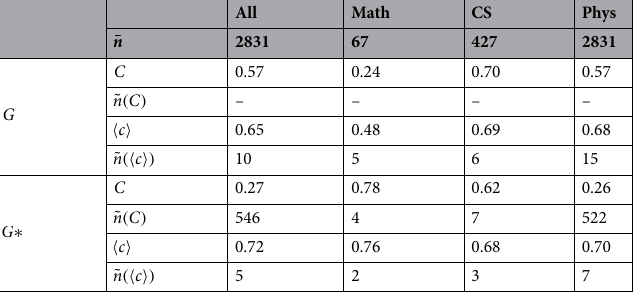
Table 3. Maturation indices and maturation values of the graphs’ clustering properties. All notations and definitions are reported in the text. The symbol “–” reflects the fact that the property does not maturate, implying that significant changes in the property’s value occur at all fusion indices, up to the final layer (the reported values are therefore the “asymptotic” ones obtained by fusing all